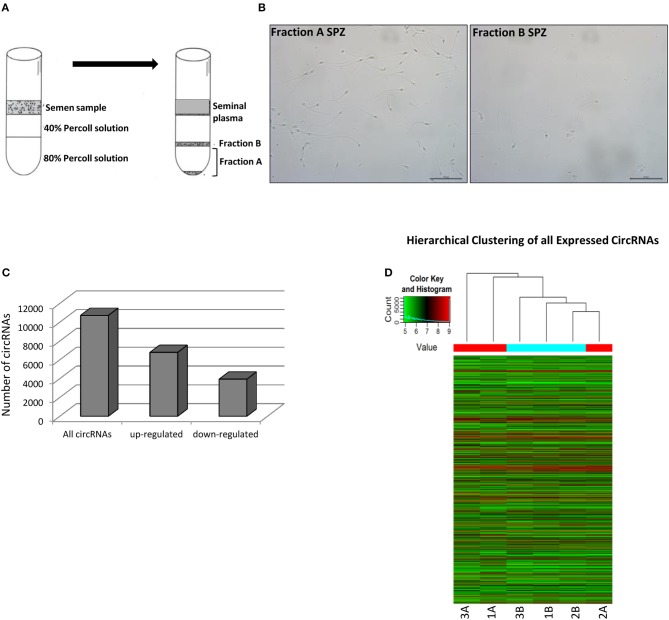
Expression of circRNAs in fraction A and B SPZ (A) Fractionation of human sperm by density gradient centrifugation. The lower and upper gradients (80 and 40%) were carefully layered and the semen sample located on the top. After centrifugation (see Materials and Methods section) clear seminal plasma was retained on the uppermost part of the gradient followed by a clear separation of white blood cells, debris and other cells. The immature, abnormal SPZ were recovered from 40% Percoll fraction (fraction B). Highly motile normal SPZ moved actively to the bottom of the gradient 80% and collected as a pellet (fraction A). (B) Fraction A and B SPZ isolated by semen using Percoll gradient visualized via optical microscopy. Scale bar 50 μm. (C) The distribution of up- and down-regulated circRNAs in fraction B compared to fraction A SPZ among all circRNAs. (D) Hierarchical clustering analysis of total circRNAs arranged samples into two groups, based on their expression levels; in detail, this analysis used different colors to represent the expression values of circRNAs detected in fraction A (n = 3, indicated as 1A, 2A, 3A) and B (n = 3, indicated as 1B, 2B, 3B) SPZ of normo-zoospermic volunteer donors.